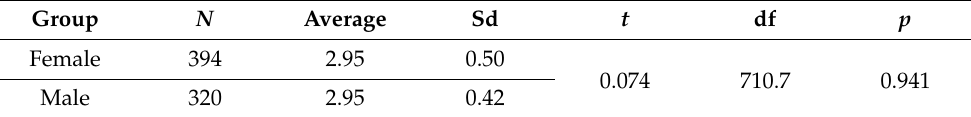
Table 5. The comparison of the opinions of refugees’ on healthcare services by gender.